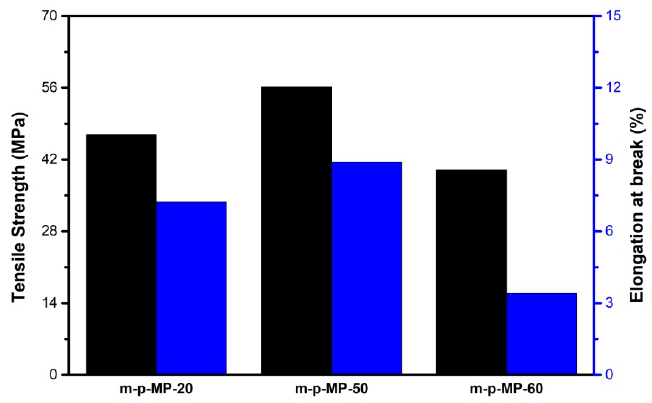
Figure 7. The mechanical properties of the m-p -MP-20, m-p -MP-50, and m-p -MP-60 membranes.